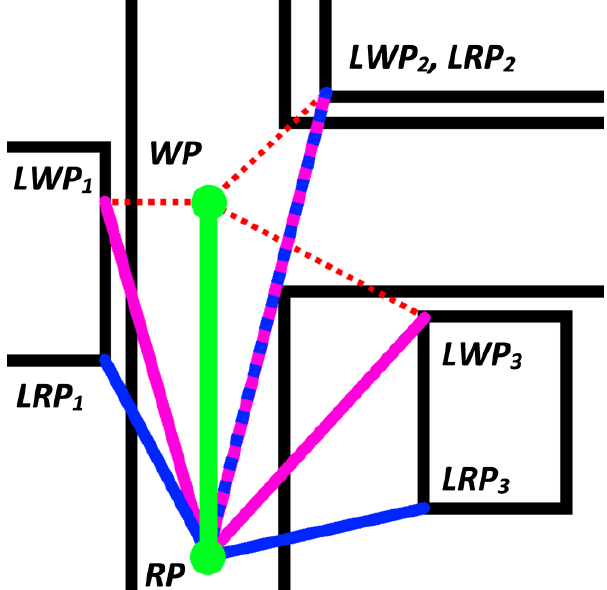
Figure 2. Calculating feature position in relation to the waypoint.